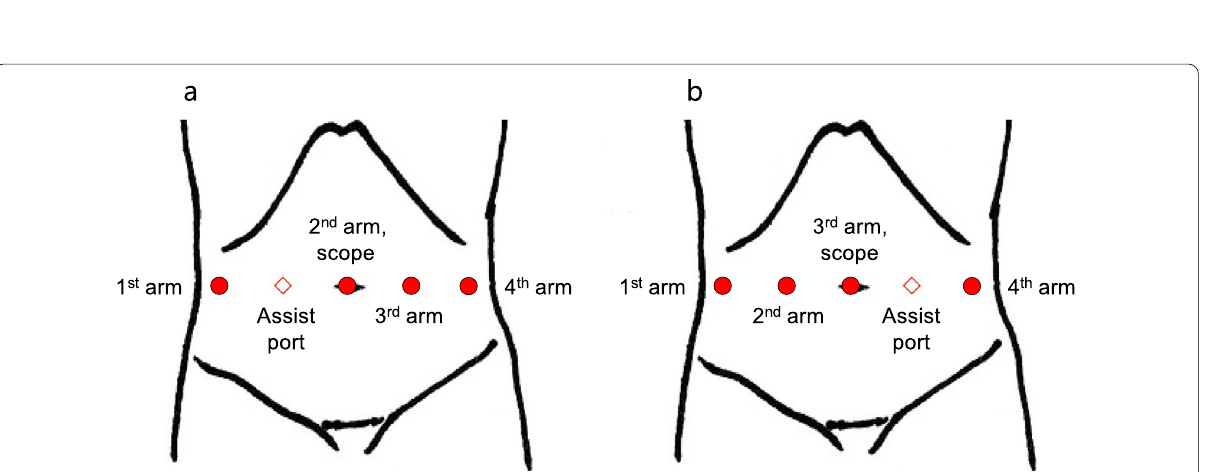
Fig. 4 Placement of the ports and robotic arms. a Our routine settings. b This